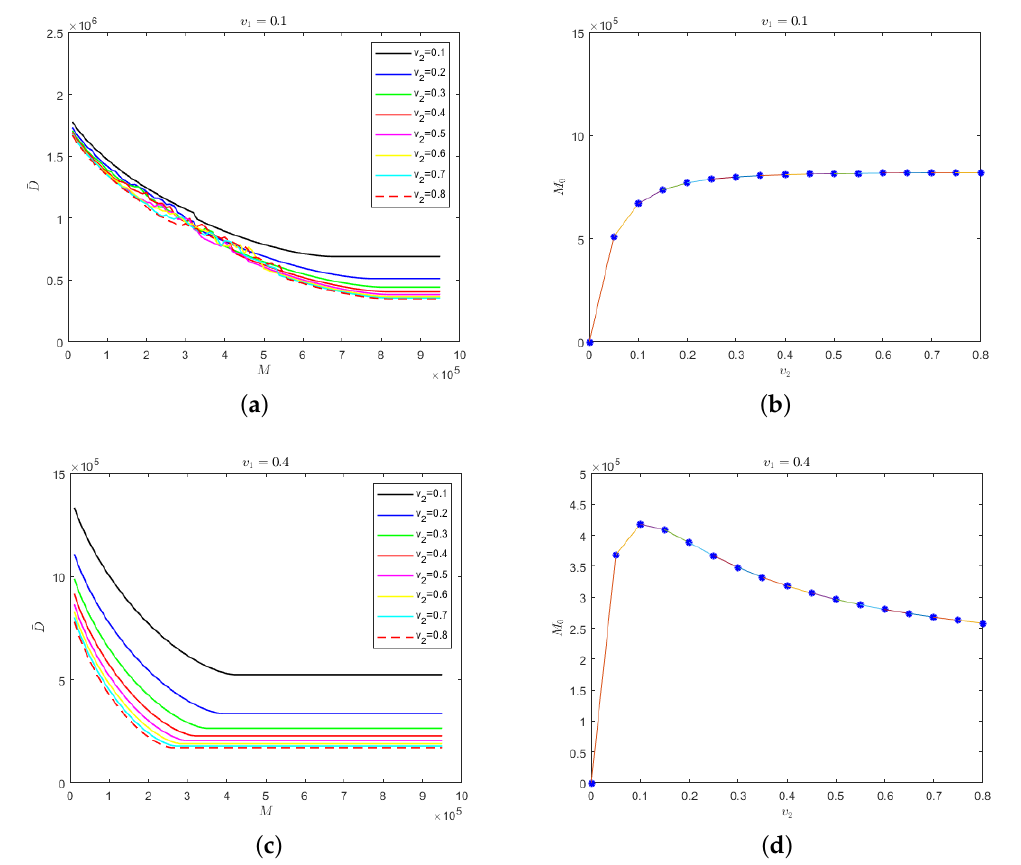
Figure 5. ( a ) Evolution results of the number of deaths in regard to the medical resources for different isolation rates of hospitalized severely infected individuals when the isolation rate of hospitalized mildly infected individuals is 0.1; ( b ) the relationship between safe medical resources and the isolation rate of hospitalized severely infected individuals when the isolation rate of hospitalized mildly infected individuals is 0.1; ( c ) evolution results of the number of deaths in regard to the medical resources for different isolation rates of hospitalized severely infected individuals when the isolation rate of hospitalized mildly infected individuals is 0.4; ( d ) the relationship between safe medical resources and the isolation rate of hospitalized severely infected individuals when the isolation rate of hospitalized mildly infected individuals is